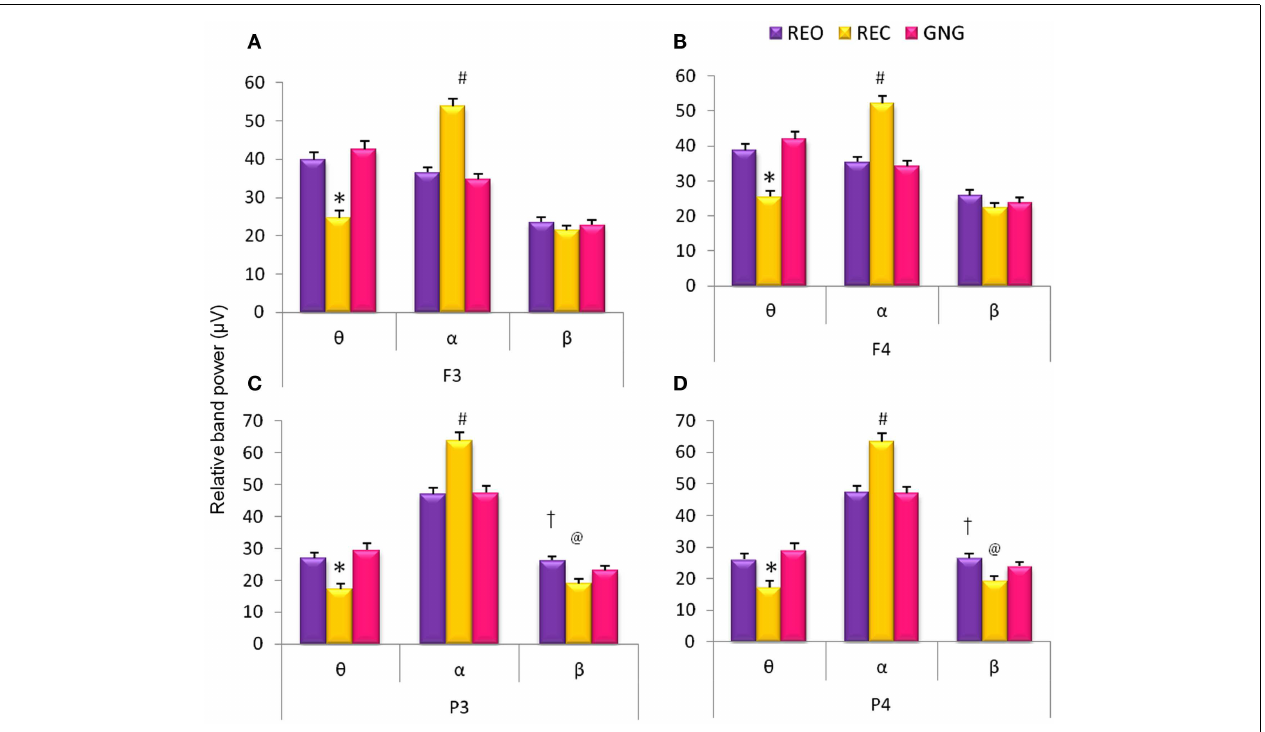
FIGURE 1 | Relative EEG frequency band power during different stages of the GNG testing session: resting eyes open (REO), resting eyes closed (REC), and the GNG task. Relative frequencies reported: theta ( θ , 4–7Hz), alpha ( α , 7–14Hz), and beta ( β , 15–30Hz) for frontal (F 3 and F 4 ) and parietal (P 3 and P 4 ) electrodes. *For all electrodes relative θ